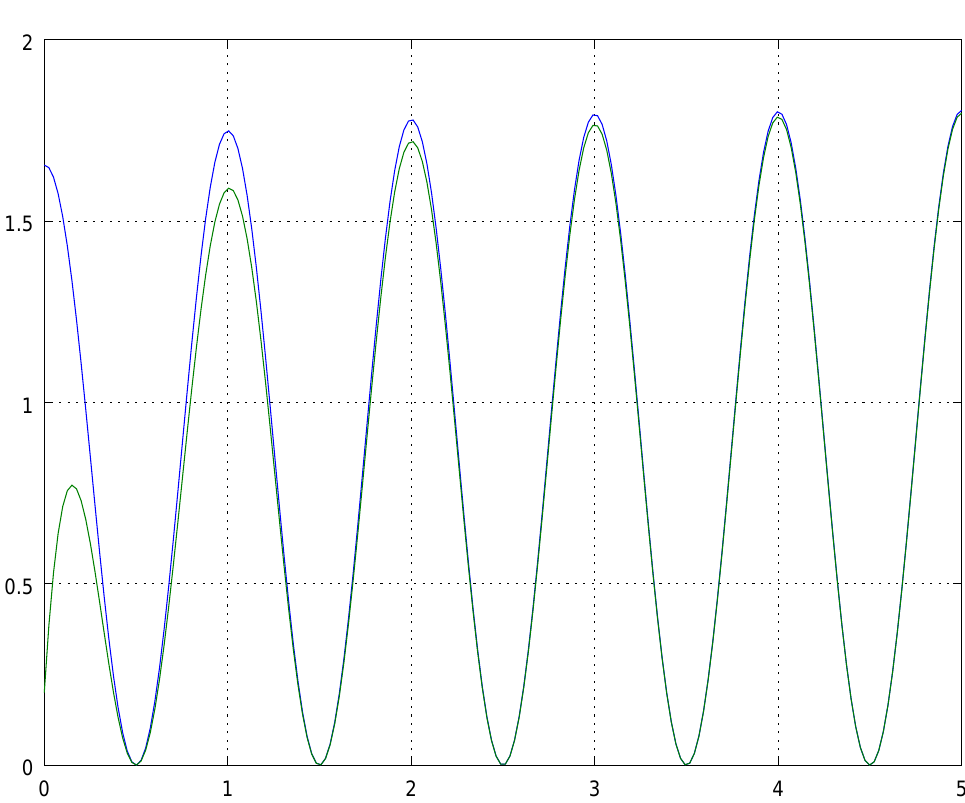
Figure 4. ˜ λ 0 under initial conditions (i) and